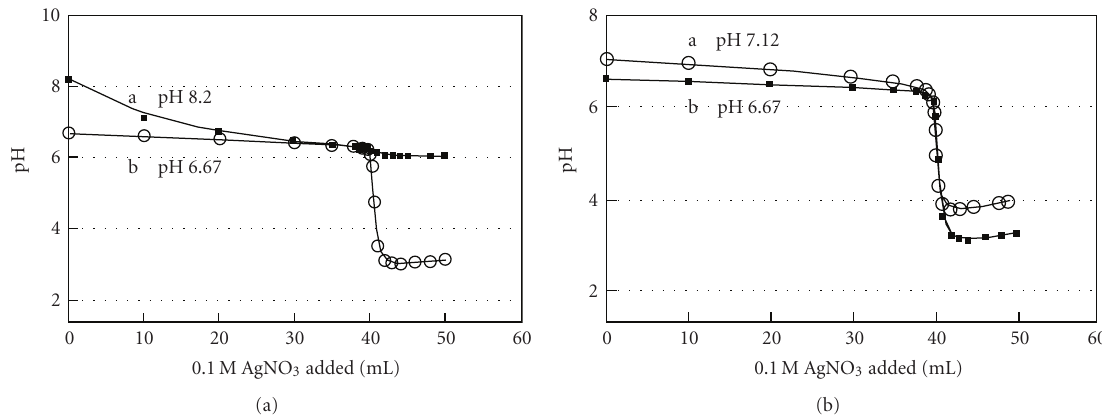
Figure 3: (a) Titration curves of 40.00mL of 0.1M NaCl with a 0.1 M AgNO 3 solution at two di ff erent bisulfite concentrations: (a) 0.50mM ( , initial pH 8.20), (b) 5.0mM ( (cid:4) , initial pH 6.67). (b) Titration curves of 40.00mL of 0.1M NaCl with a 0.1 M AgNO 3 solution in the (cid:0) presence of 5.0mM bisulfite at two di ff erent initial pH values: (a) 7.12 ( (cid:4) ), (b) 6.67 (